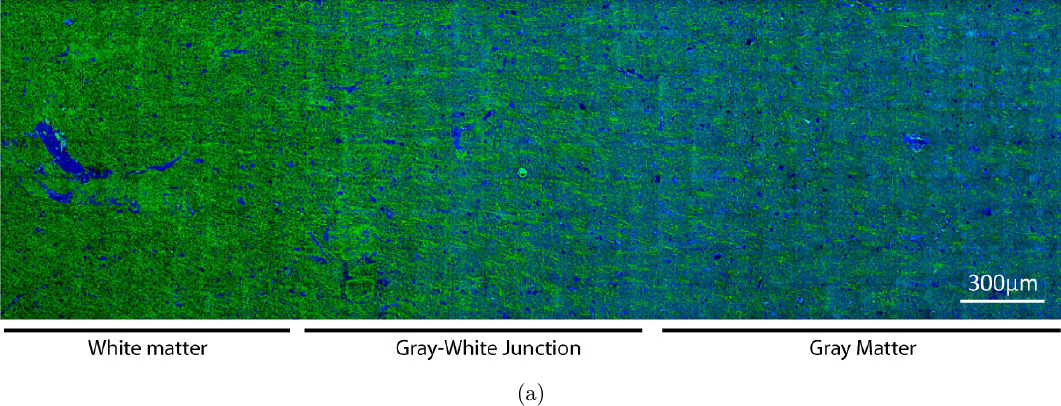
Fig. 4. SRS images of normal human brain surgical tissues: (a) Fresh tissue with a transition from white to gray matter and (b) gray – white junction imaged with frozen tissue sections, compared with H&E and LFB